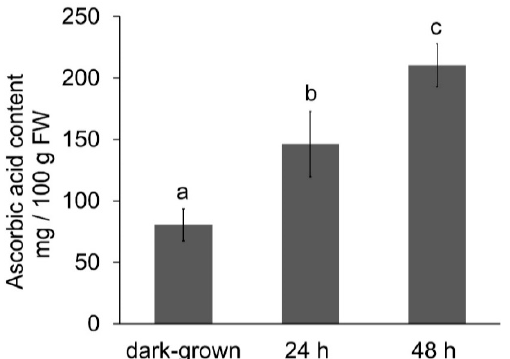
Figure 3. Ascorbic acid (AA) content in dark-grown chia microgreens and microgreens after exposure to light for 24 and 48 h. Data represent mean values from three experiments with five replicates (n = 15). The error bars show standard deviation (SD). Different letters signify values that are statistically different at p ≤ 0.05 according to Fisher’s LSD test.